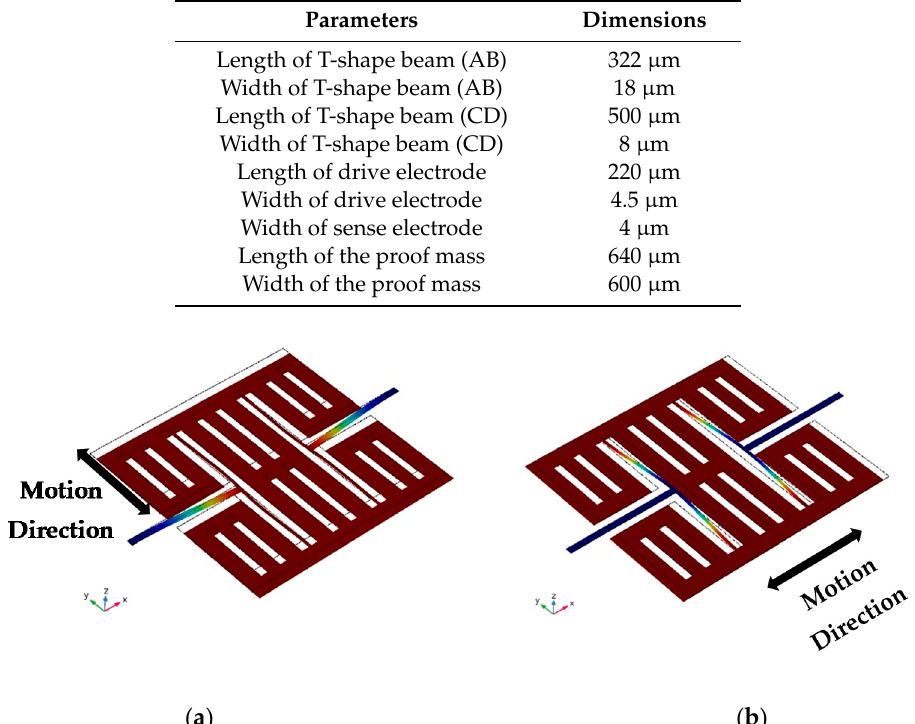
Figure 4. The displacement simulation of the drive mode ( a ) and sense mode ( b ) of an AlN MEMS gyroscope.